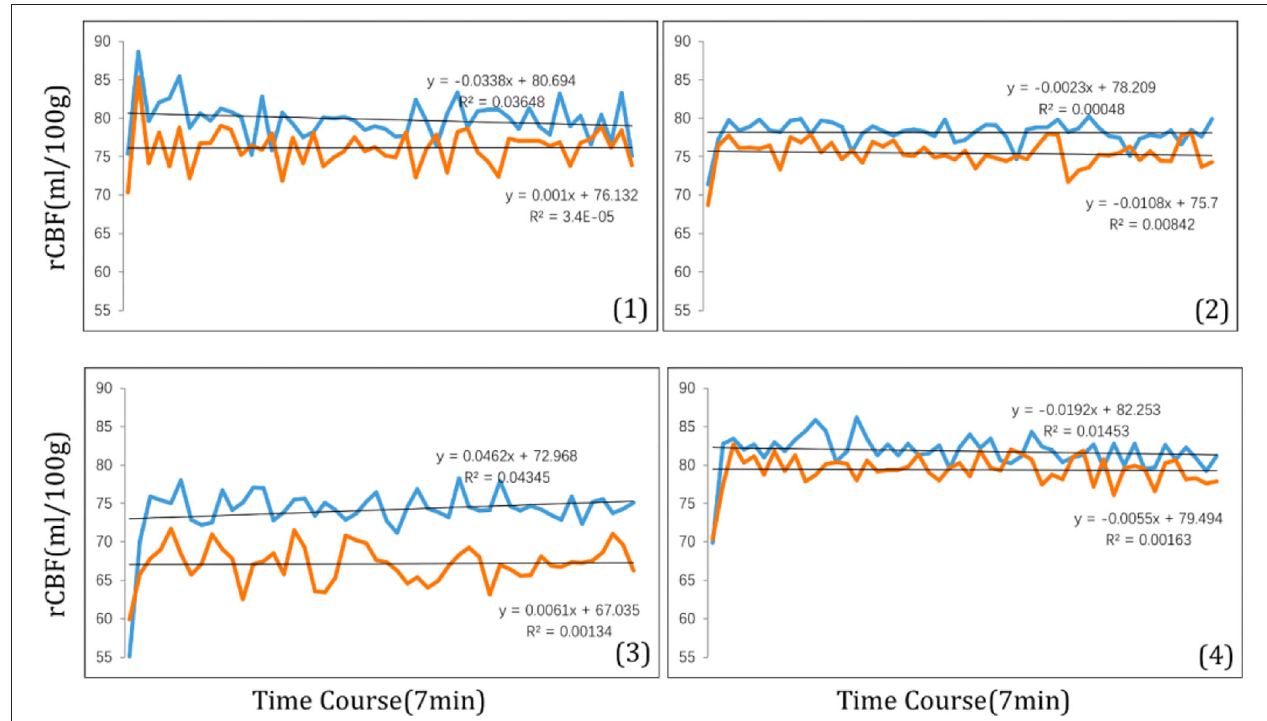
FIGURE 6 | The time course of rCBF signal intensity (ml/100g) within 7min in four ROI: (1) right precentral gyrus; (2) right superior temporal; (3) left inferior parietal lobule; (4) left middle temporal gyrus. The blue curve stands for myopic defocus, orange curve stands for clear